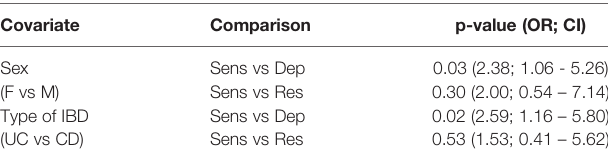
TABLE 2 | Multivariate analysis considering all covariates signi fi cant in the univariate analysis. Covariate Comparison p-value (OR;